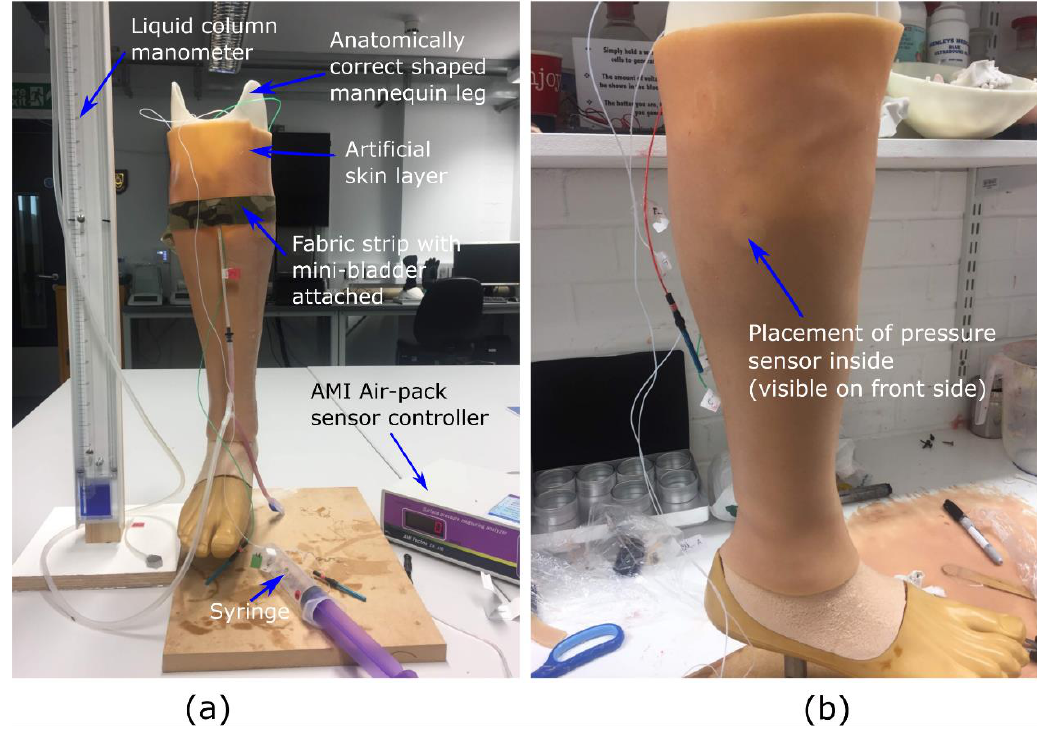
Figure 3. The experimental set up used to evaluate the pressure transmission efficiency, ( a ) measurement set up ( b ) the AMI. senor embedded in the fat layer visible through the skin layer.